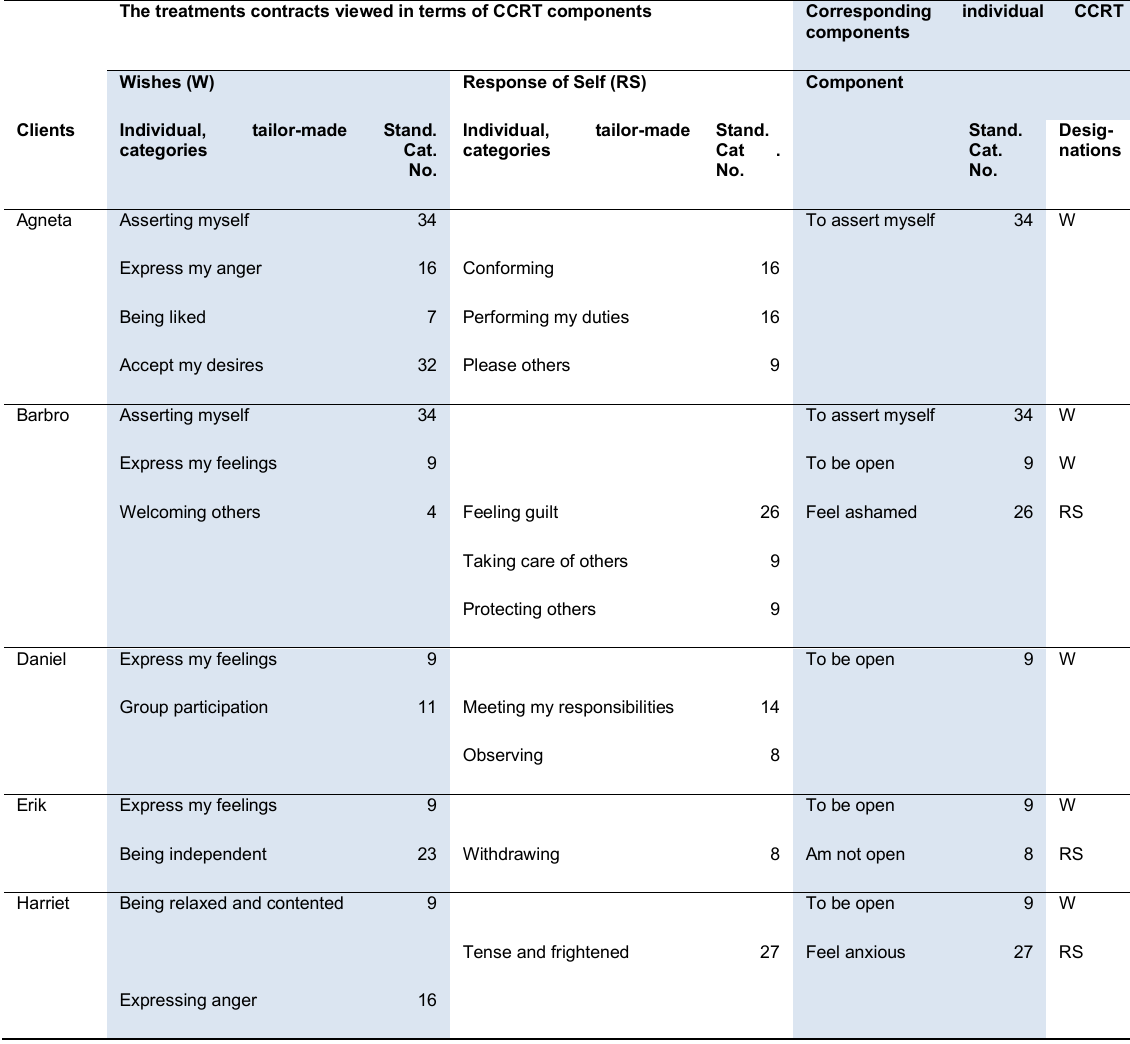
Table 5: Correspondence between the clients CCRT categories contained in the treatment contracts and in the individual CCRT